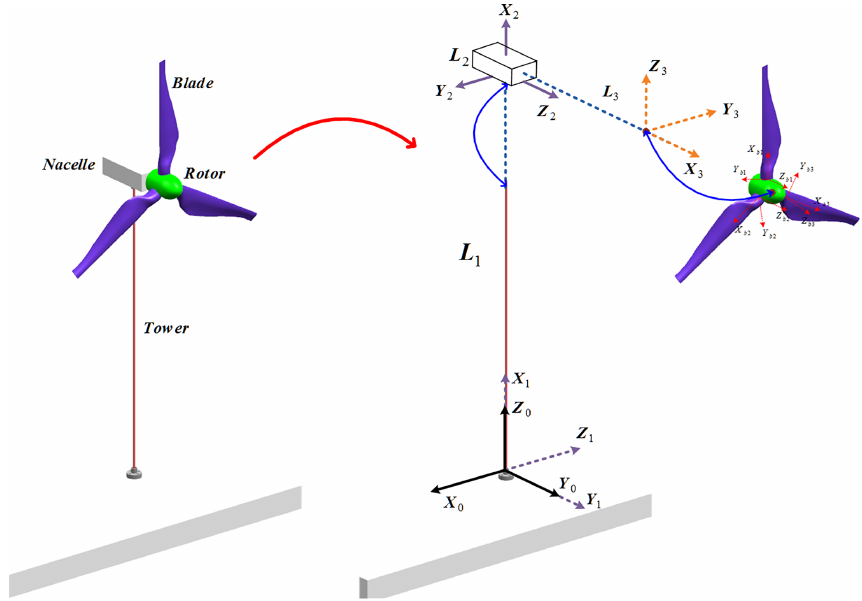
Figure 3. Interconnected bodies of wind